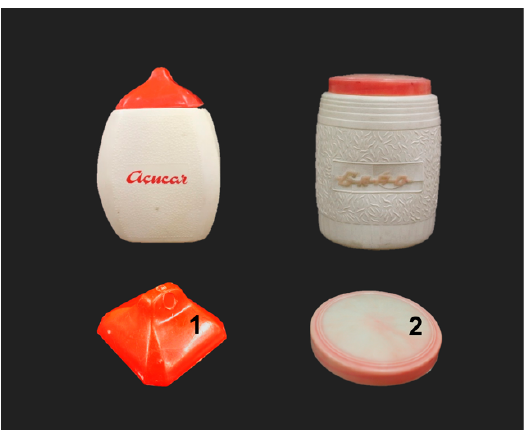
Figure 1. The historical plastic objects under study, lid 1 made of PE with PR 48:2 ( bottom left ), lid 2 made of PE with PR 53:1 ( bottom right ).